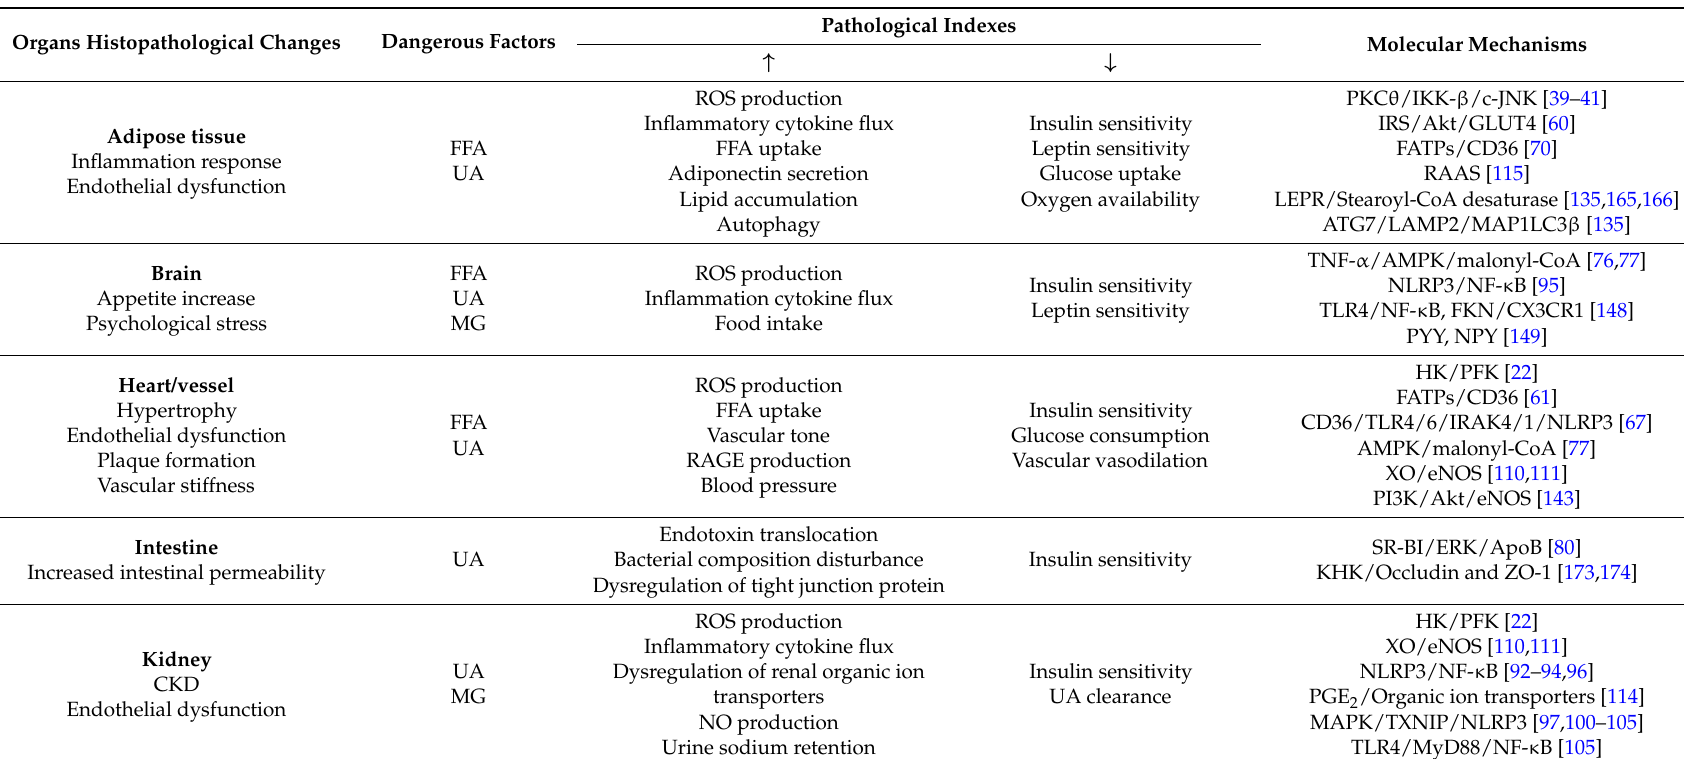
Table 1. Pathological changes of major organs and molecular mechanisms of tissue dysfunction under high fructose